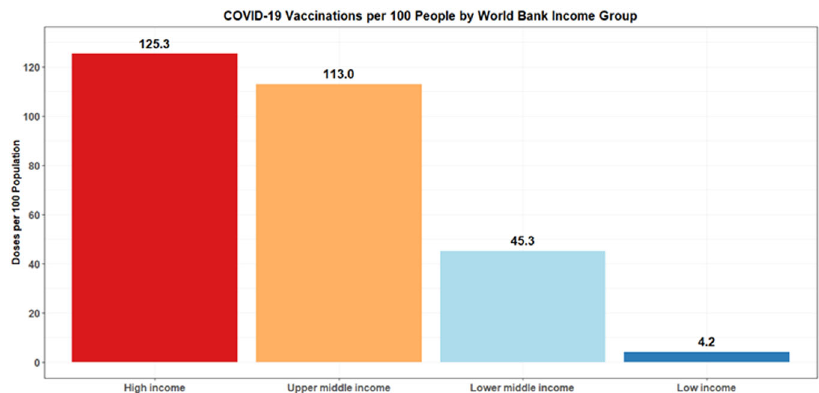
Fig. 1 Global distribution of covid-19 vaccinations by world bank country income groups. The rate of vaccination doses administered per 100 population is shown as of October 1st, 2021, separate by world bank county income groups, according to data from